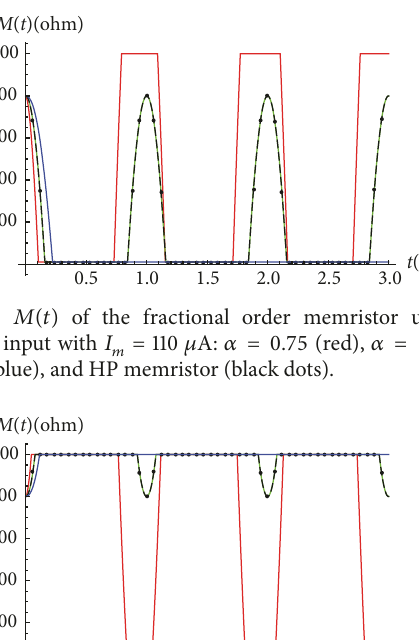
Figure 3: 𝑡 𝑠𝑎𝑡(𝑀𝐴𝑋) of the current-controlled fractional order mem- ristor against |𝐼 𝐷𝐶 | : 𝛼 = 0.75 (red), 𝛼 = 1 (green), and 𝛼 = 1.25 (blue).